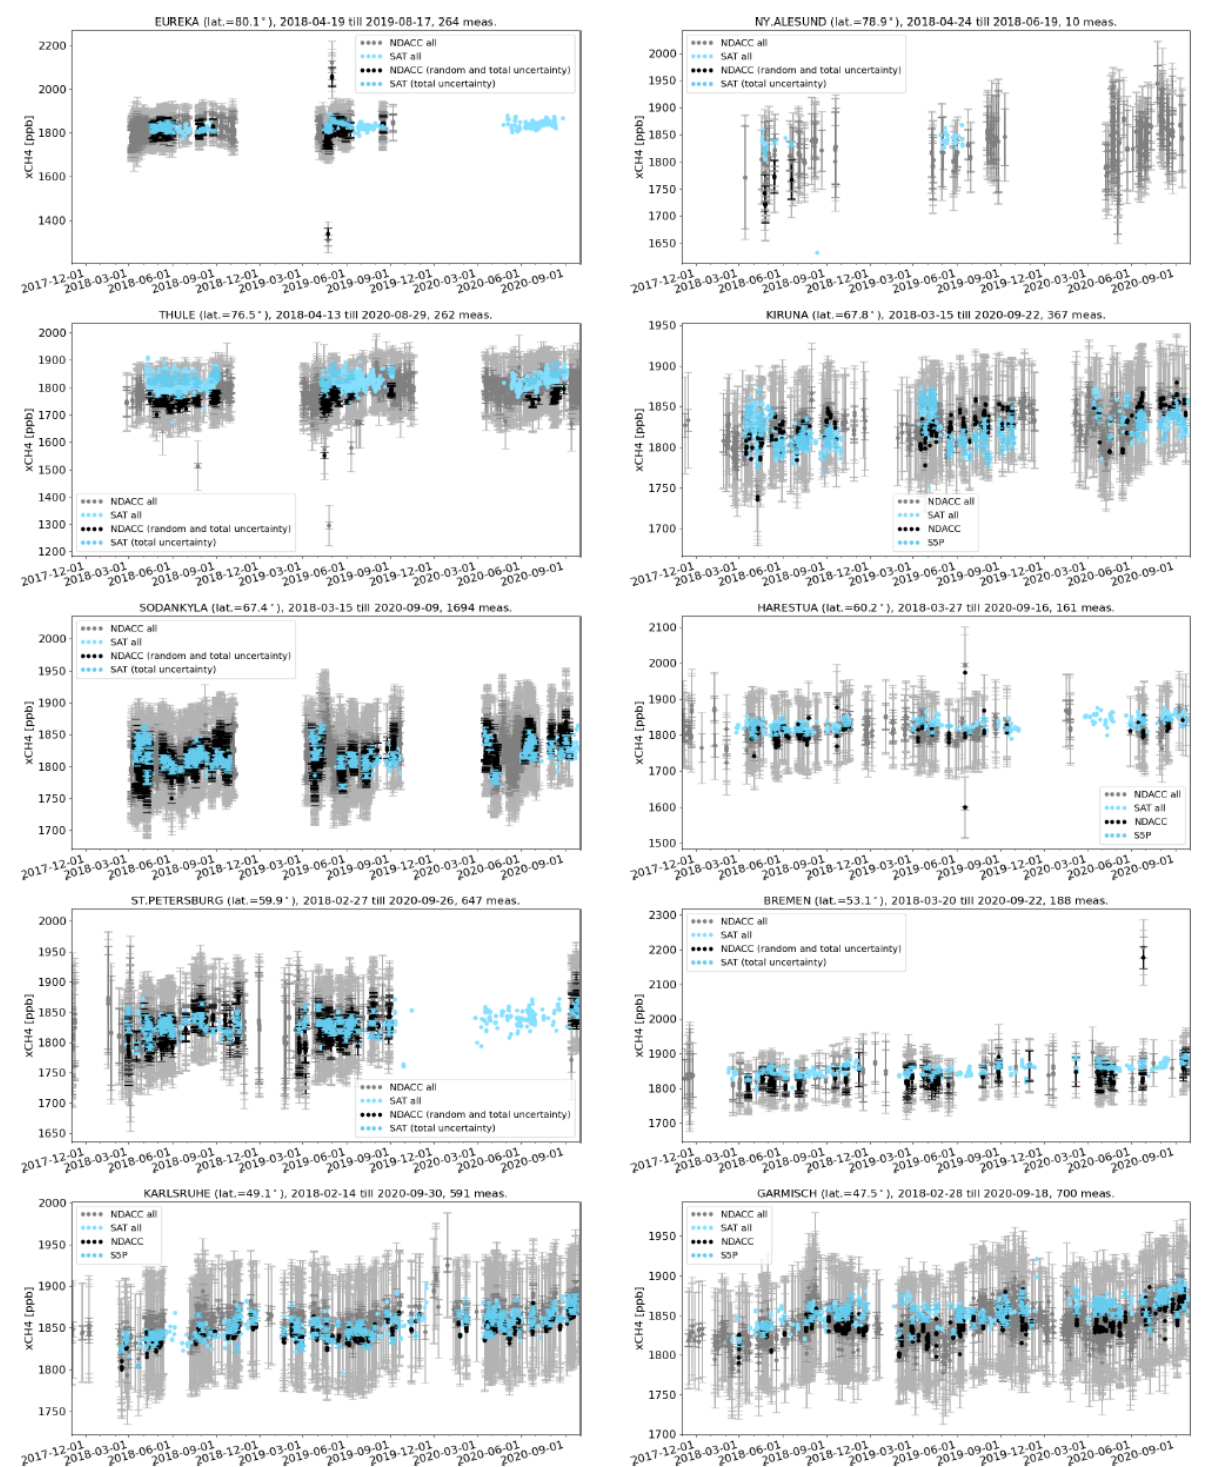
Figure 12. XCH 4 time series for all NDACC data (grey), S5P bias-corrected data (light cyan), S5P data co-located with NDACC data (cyan) and co-located NDACC data smoothed with S5P a priori and additionally smoothed with the S5P column-averaging kernel (black) at each site ordered with decreasing latitude. Spatial co-location with radius of 100km and time of ± 3h around the satellite overpass was